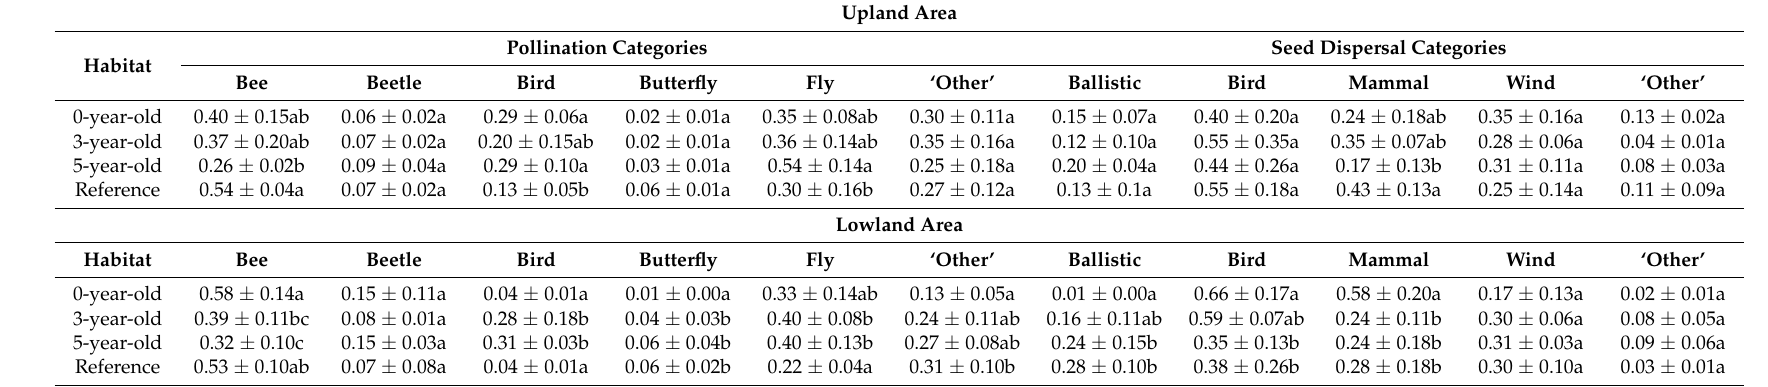
Table 3. Species pollination and seed dispersal categories proportion across habitats (mean ± SD).